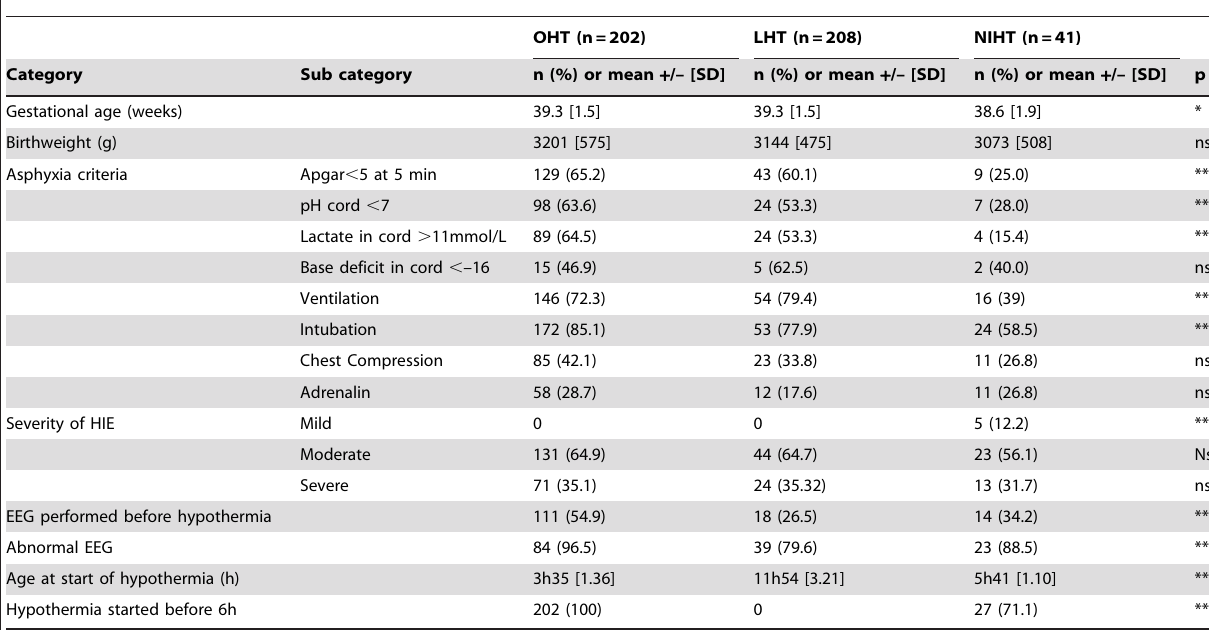
Table 2. Criteria indicating HT according to HT